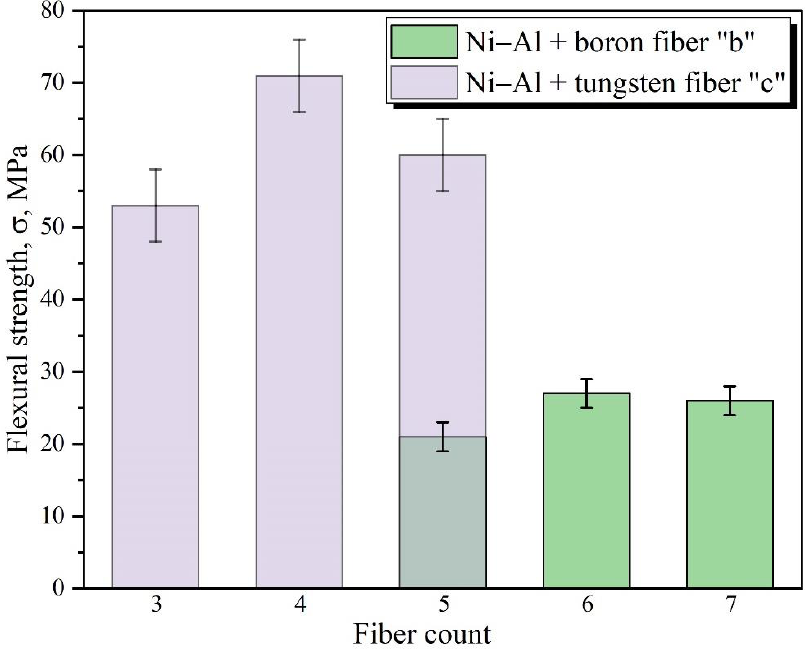
Figure 6. Flexural strength of specimens as a function of the number of fibers in one layer.